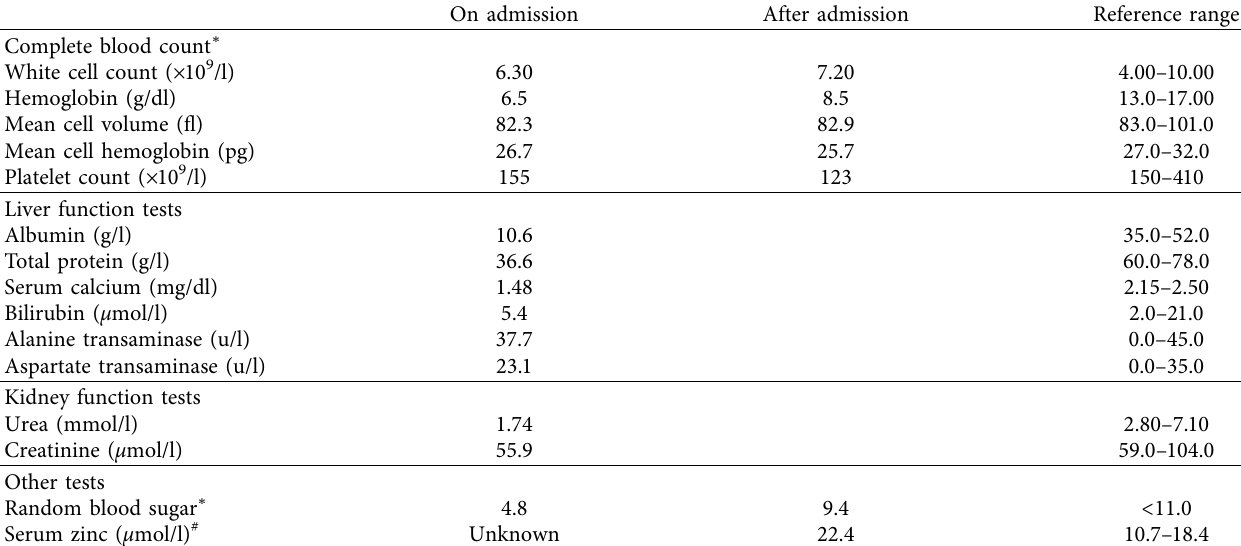
Figure 1: Dermatological manifestations on admission showing (a) hair dyspigmentation and alopecia; (b) perioral dermatitis and glossitis; and (c), (d) bullae and Table 1: Laboratory investigations conducted.